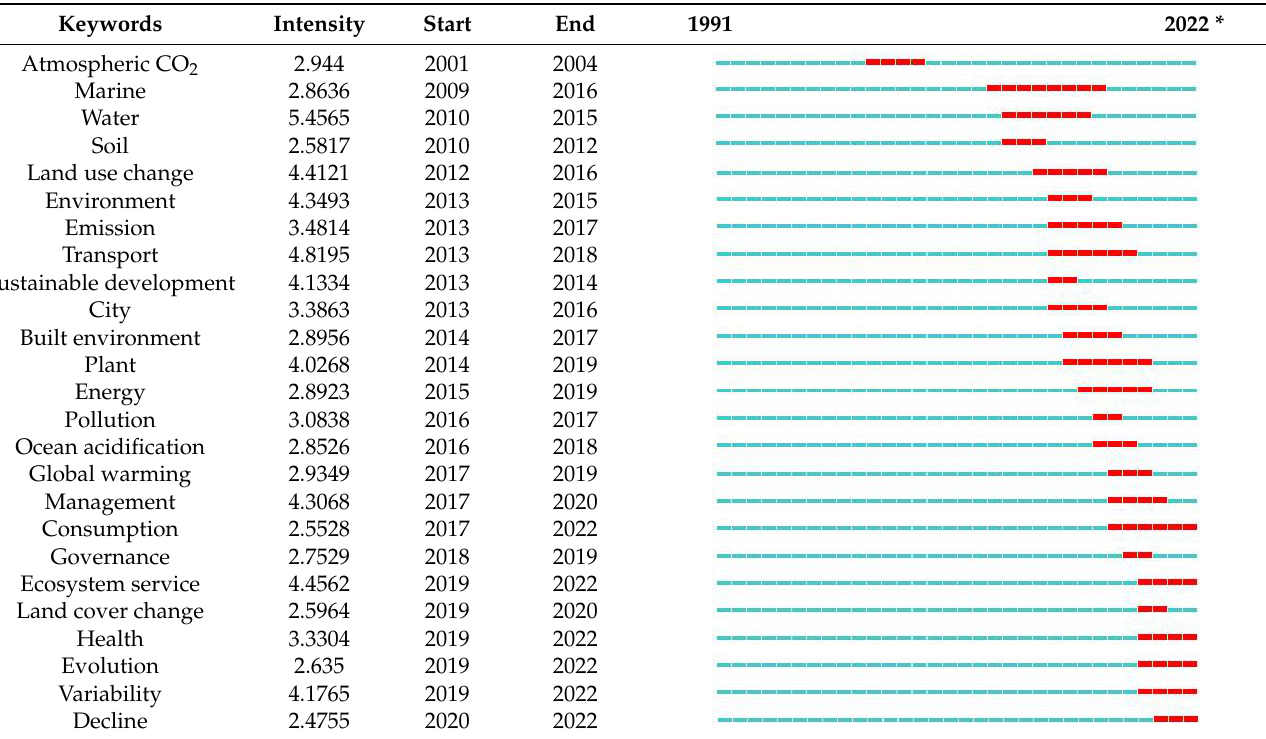
Table 3. Top 25 burst keywords for RCHSCC, 1991–2022.